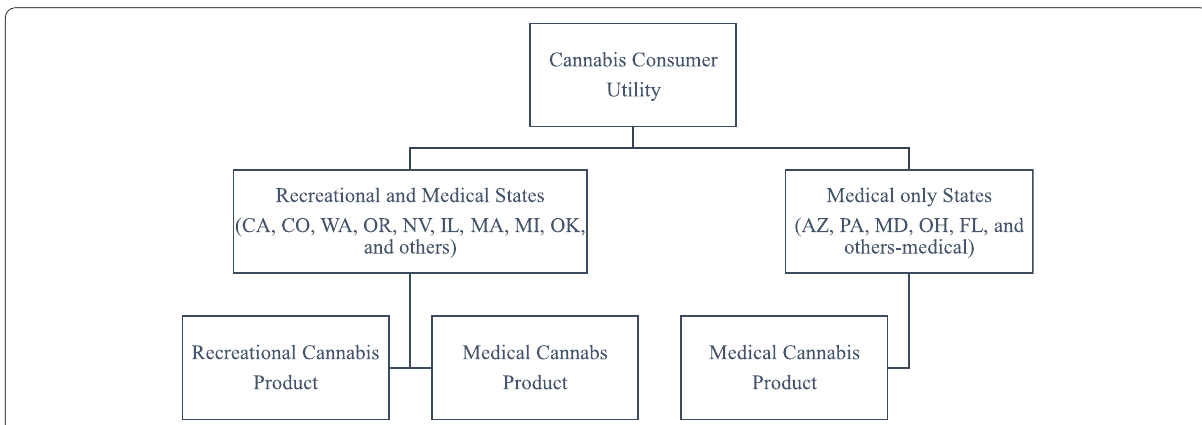
Fig. 2 Structure of nested CES utility function of cannabis consumers after recreational cannabis is legalized in